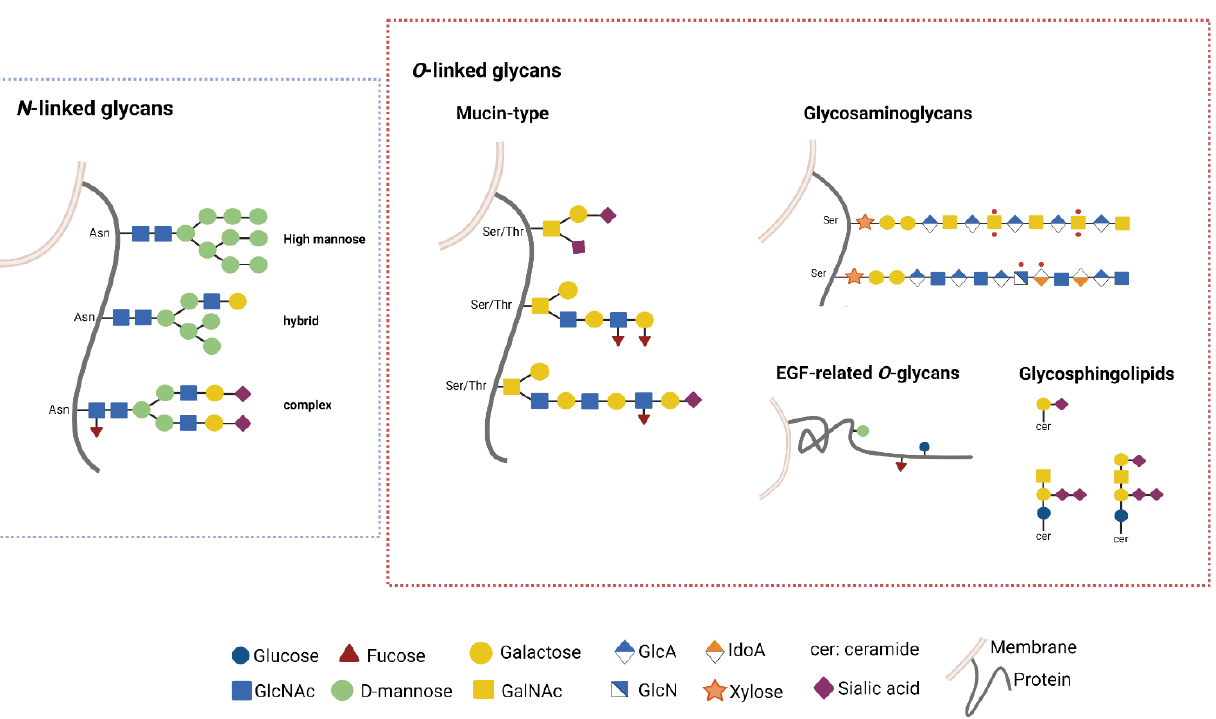
Figure 2. Common N - and O -glycan structures . Extracellular proteins are mainly glycosylated by the addition of monosaccha- rides in N - or O -linkage. N -glycans share a common core region in which the oligosaccharide N -Acetyl-D-glucosamine (GlcNAc) is covalently linked to the asparagine (Asn) residue. The elongation process through the linkage of D-mannose (Man) and the addition of other motifs, as such as Sia and Gal, led to the generation of High mannose, hybrid and complex N- glycoconjugates. O -glycosyla- tion starts from the binding of monosaccharides, as such as N -acetyl-D-galactosamine (GalNAc) to serin/threonin (Ser/Thr) residues. GalNAc represents the substrate for further elongation of Mucin-type O - glycans. Other O -glycan structures include O -xylose (Xyl) for glycosaminoglycans, O - D-glucose (Glc) for glycosphingolipids, and O -Glc, fucose (Fuc) or Man for the EGF-related O -glycans. Created with BioRender.com